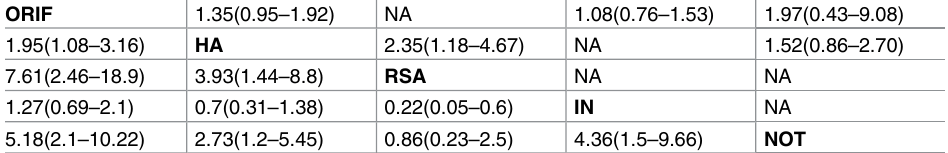
Table 4. Results for total complications, from network meta-analysis (lower diagonal part) and pair- wise meta-analysis (upper diagonal part).